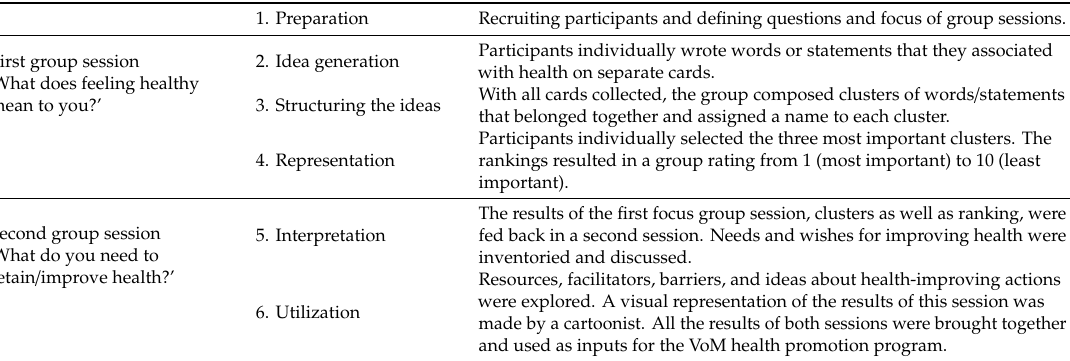
Table 2. Short description of concept mapping procedure based on Trochim [52,53].